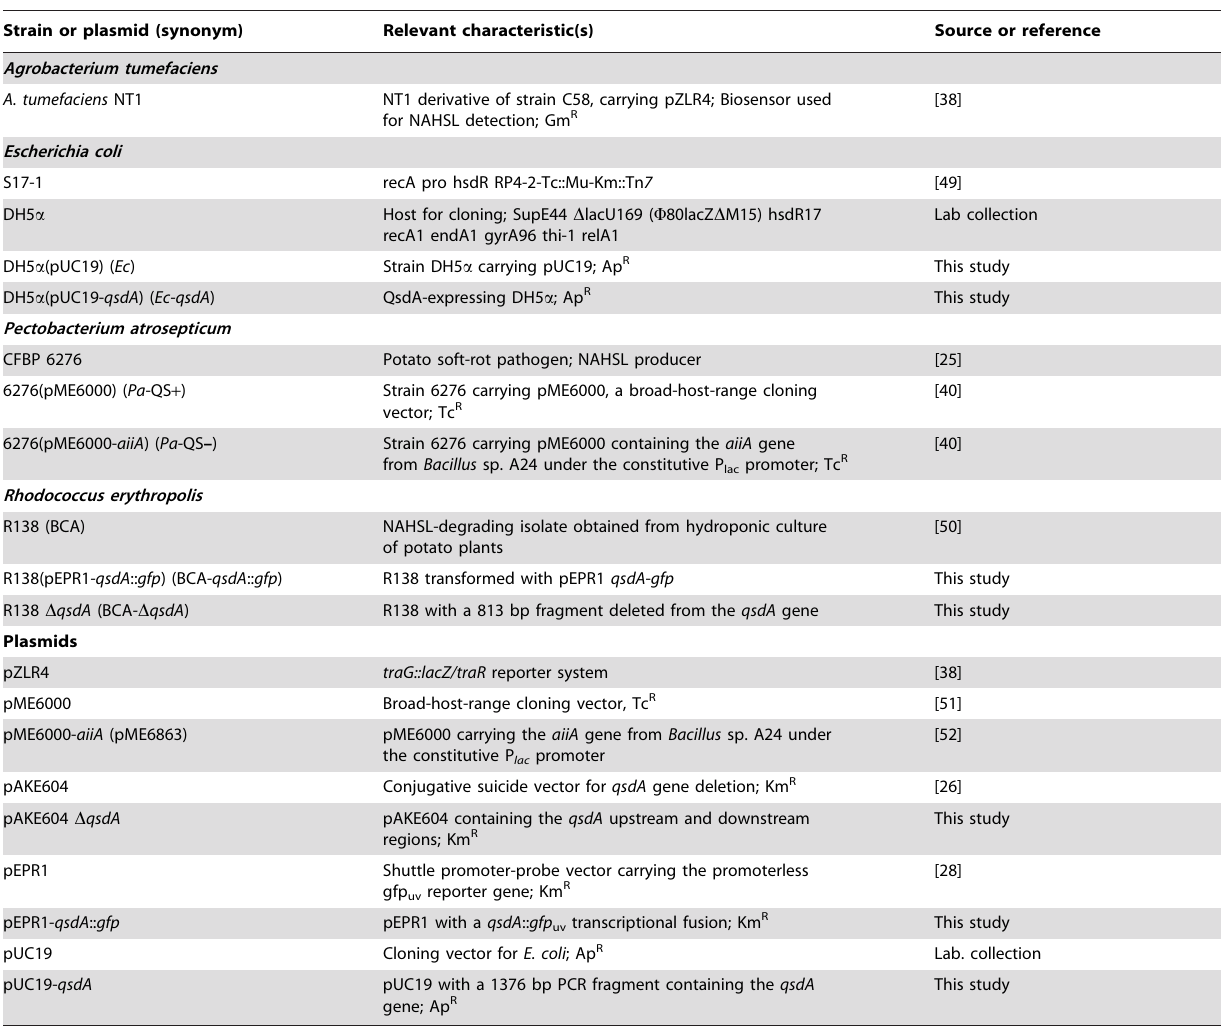
Table 1. Bacterial strains and plasmids.